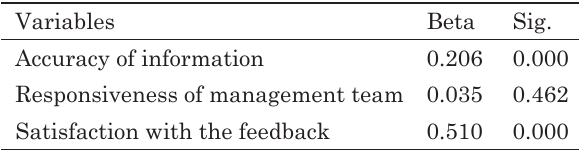
Table 6. Regression model